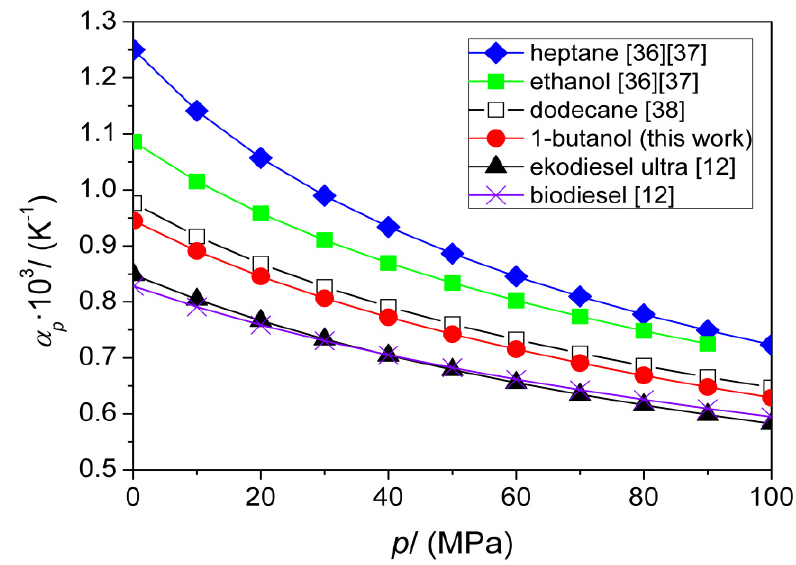
Figure 15. The pressure dependence of isobaric thermal expansion of heptane and dodecane—fuel components, ethanol—the most common used bioalcohol, low sulfur diesel oil (ekodiesel ultra) and biodiesel (FAME) at 298.15 K.